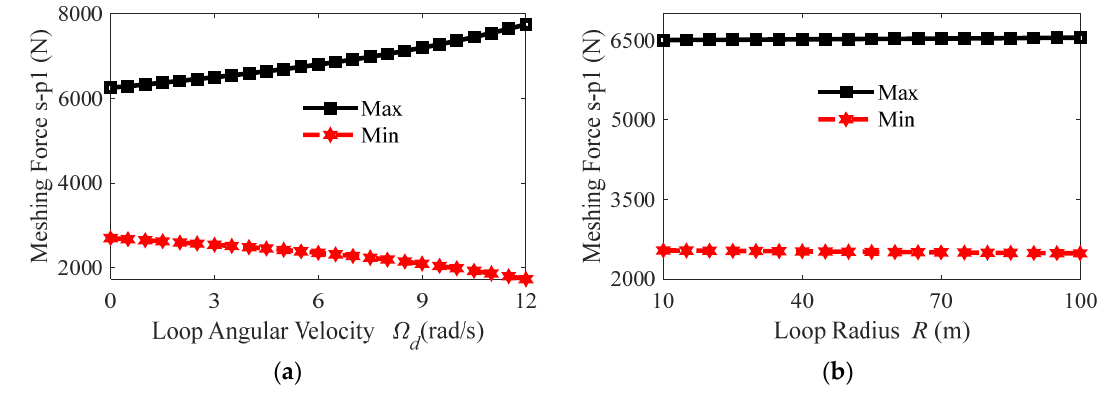
Figure 12. The maximum and minimum values of dynamic meshing force within 0.3s. ( a ) At different LAV; ( b ) At different LR.